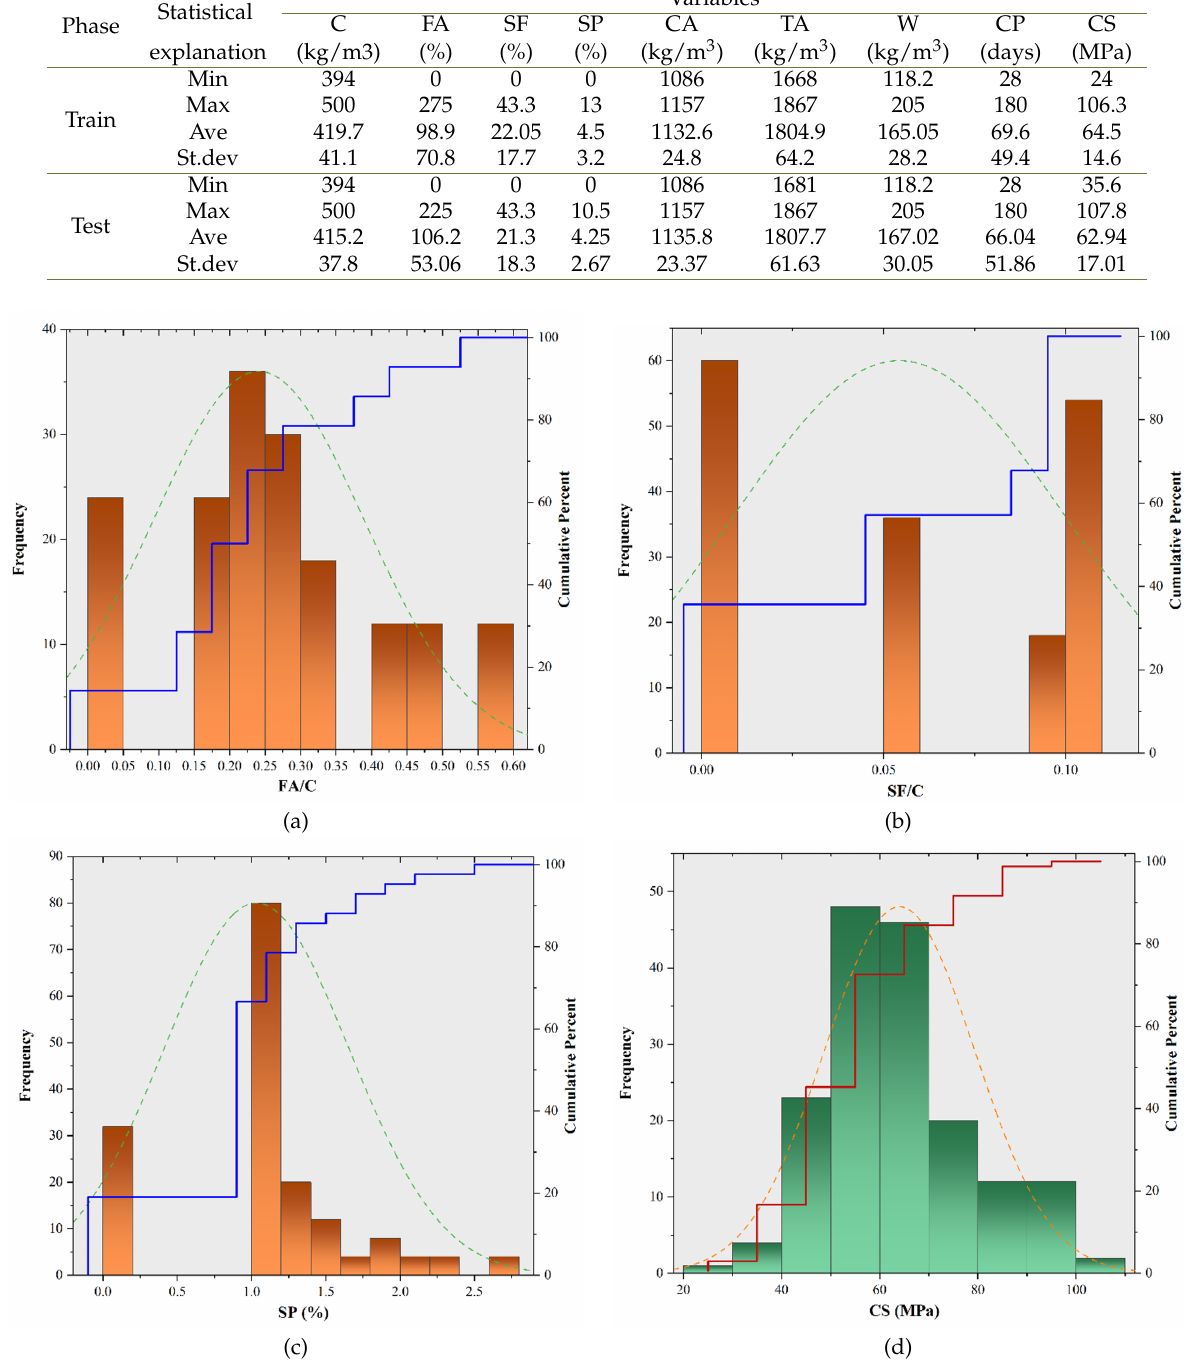
Fig. 2. cumulative percent and frequency histogram of significant hybrid models entries: a) fly ash/cement b)